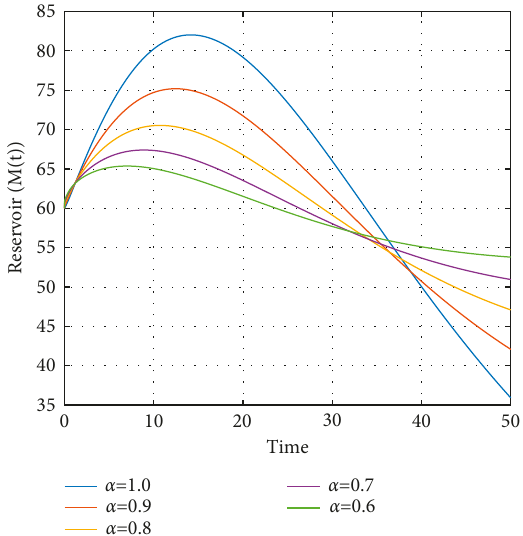
Figure 8: The graph describes the dynamics of the ratio of reservoir for different value of the fractional parameter ( σ ) , and the model parameters value are: Λ � 0 . 4, β